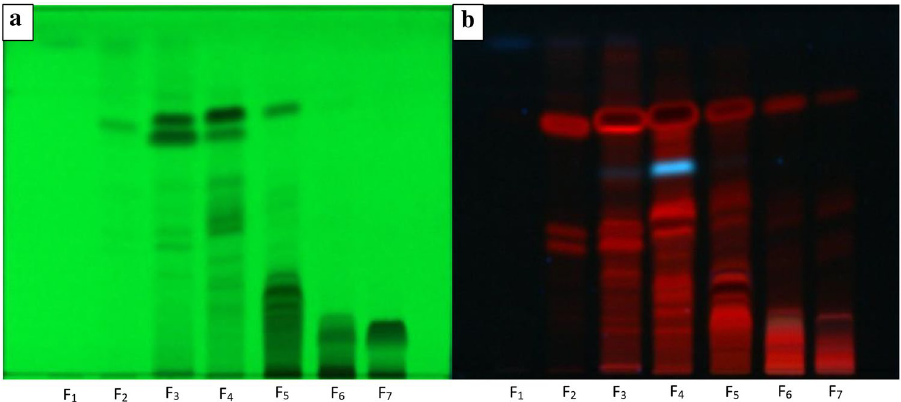
Figure 1. TLC Chromatogram from Xylocarpus granatum leaves ethyl acetate extract fraction 1 to fraction 7 (F 1 to F 7 ) using mobile phase chloroform:dichloromethane 9:1 (v/v) with ( a ) UV exposure at 254 nm and ( b ) 366